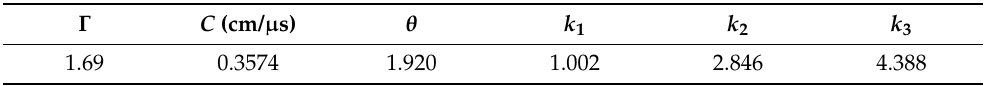
Table 1. Mie–Gr¨ υ neisen state equation parameters.